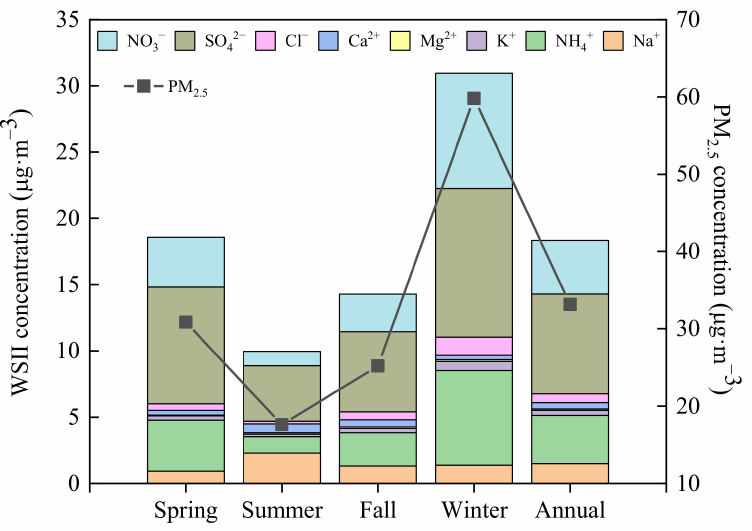
Figure 2. Seasonal variations of PM 2.5 and